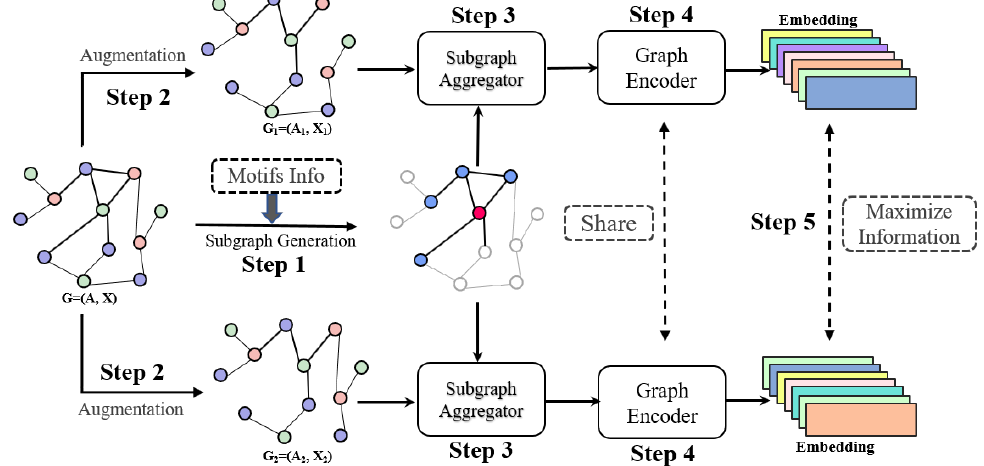
Figure 2. The over all architecture of the proposed PASCAL for unsupervised node classification, which uses feature masking as augmentation strategy. The model mainly consists 5 components: (1) subgraph generator; (2) augmentation; (3) subgraph aggregator; (4) graph encoder; and (5) com-